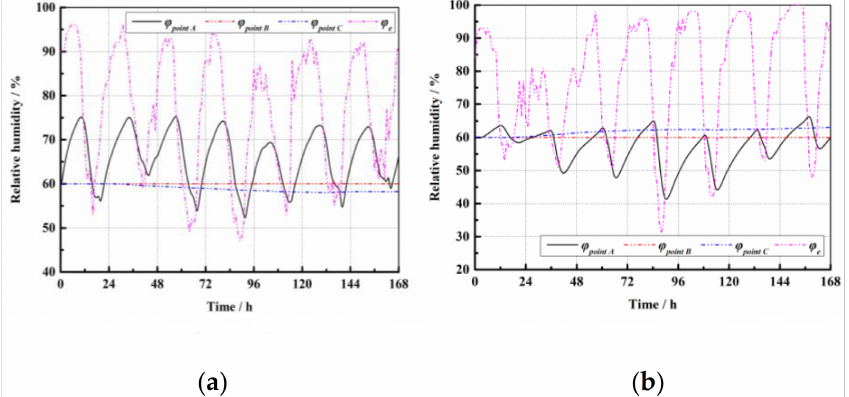
Figure 7. The relative humidity distribution of the rammed earth wall: ( a ) the relative humidity distribution of the rammed earth wall in summer; ( b ) the relative humidity distribution of the rammed earth wall in